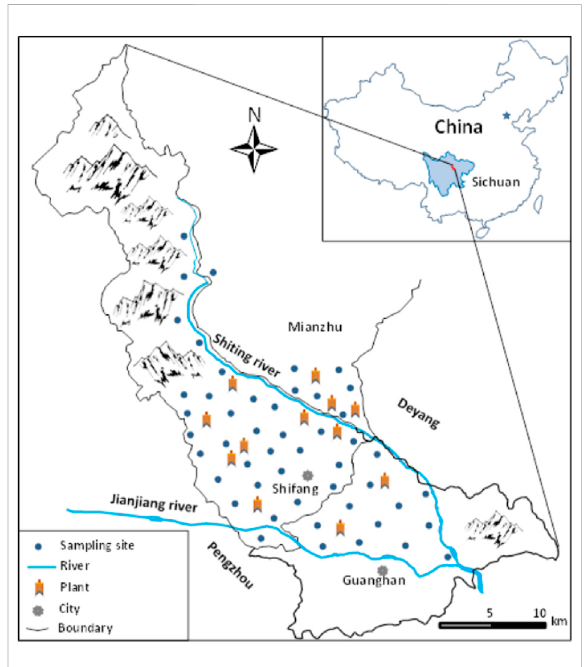
FIGURE 1 Schematic map of sampling sites in the study area, Sichuan province (southwest